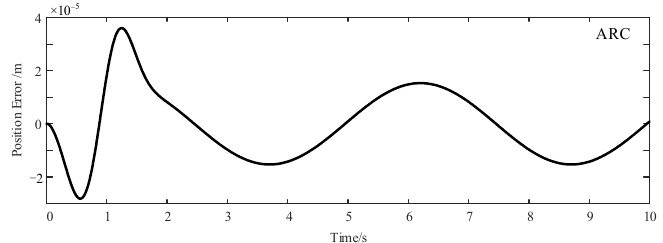
Figure 6. ARC Tracking Error of 0.2 Hz Sinusoidal Signal.